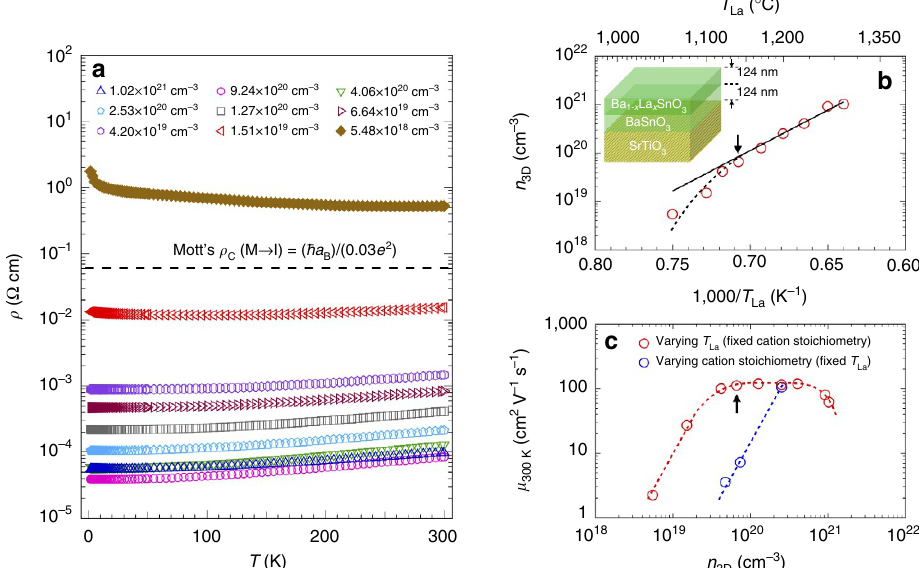
Figure 2 | Temperature dependence of resistivity and the influence of charge compensation on room temperature carrier density and mobility. ( a ) Resistivity ( r ) of doped BaSnO 3 films as a function of temperature ( T ) for different free carrier concentration measured at 300K. ( b ) Free carrier concentration ( n 3D ) at 300K as a function of La cell temperature ( T La ) representing dopant concentration. Inset shows the schematic of the structure used, and ( c ) m 300K versus n 3D for stoichiometric (red open circles) and Ba-deficient films (blue open circles). Non-stoichiometric films had 31nm of buffer and active layer thicknesses. Black arrows mark the onset of charge